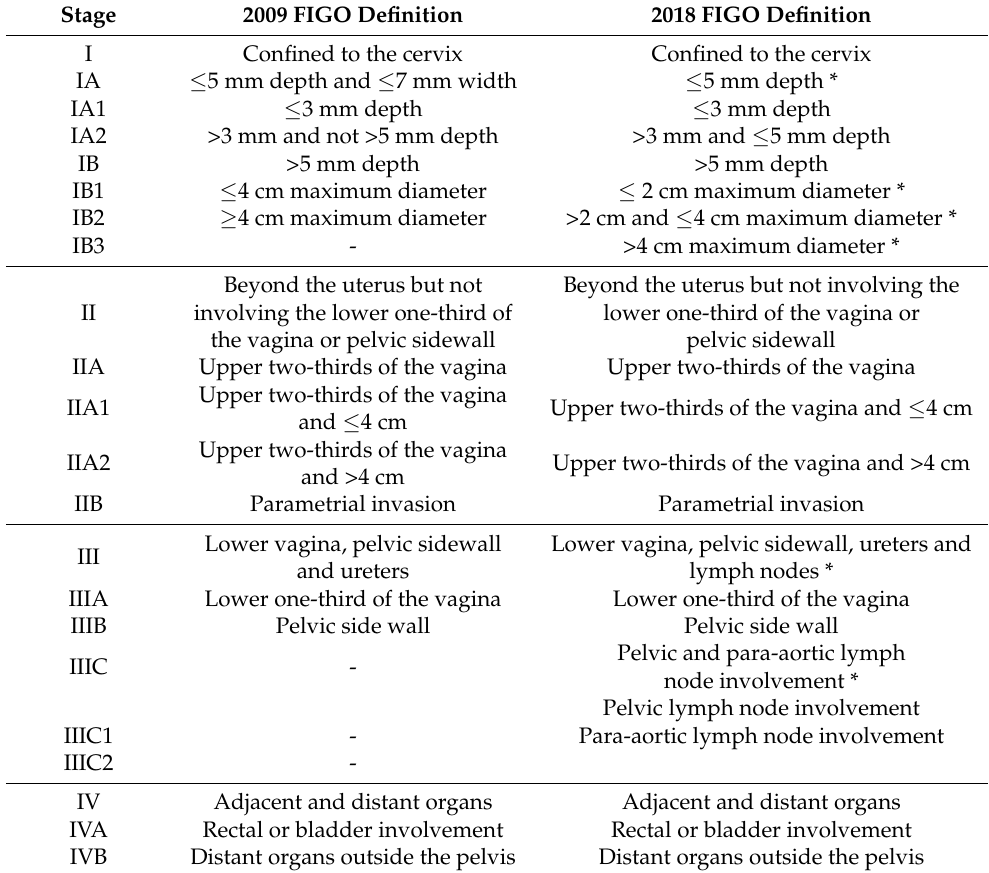
Table 1. Comparison of the 2009 and 2018 FIGO staging